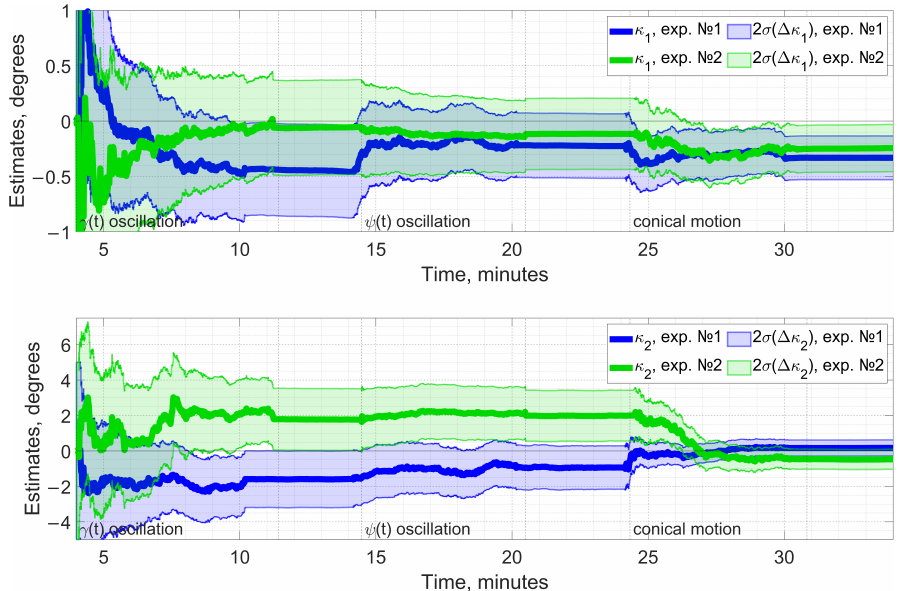
Figure 7. Estimates for κ 1 ( top ), κ 2 ( bottom ) and their corresponding 2- σ confidence intervals (semitransparent) in two similar experiments. The intervals eventually overlap with a desired sub-degree level of precision, indicating consistent